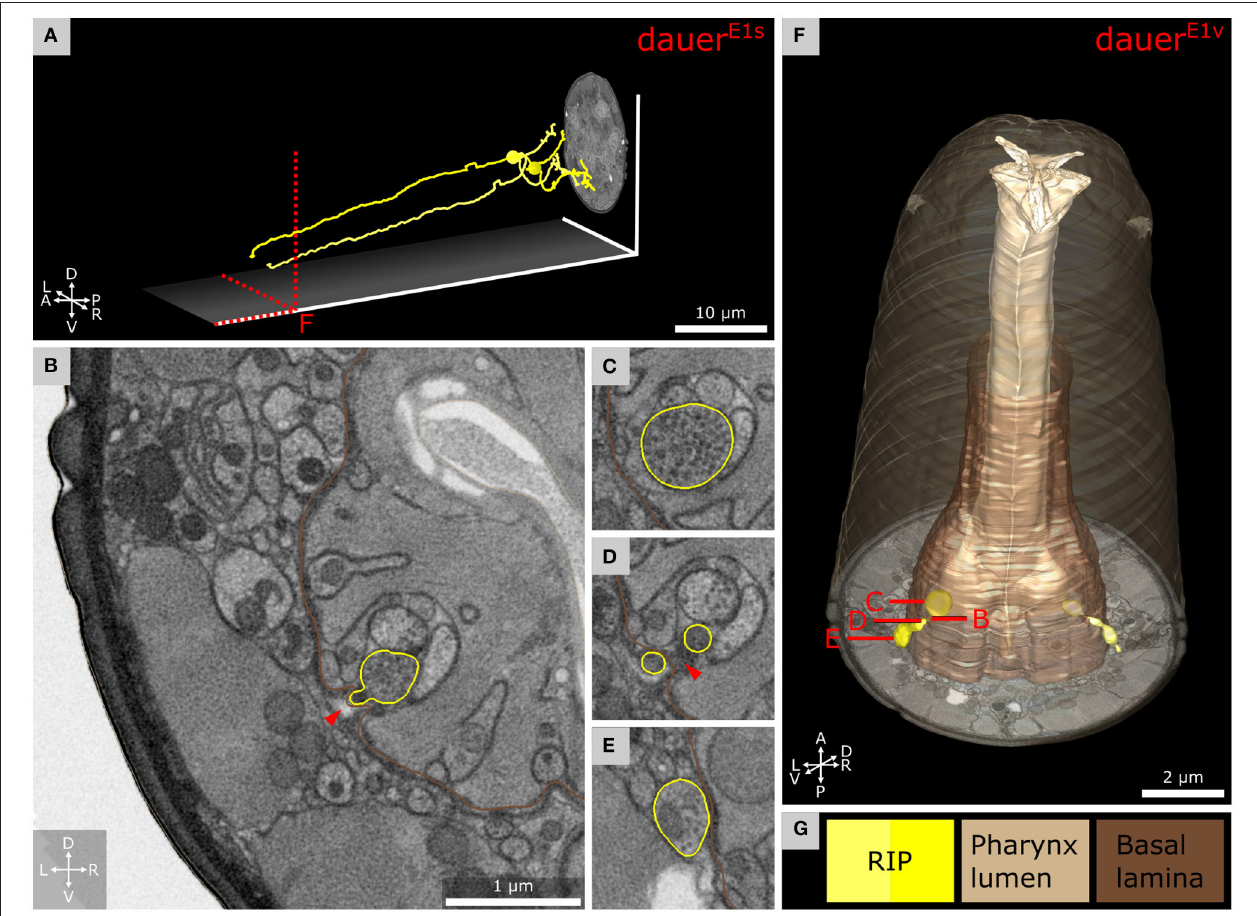
FIGURE 7 | Anterior dendritic endings of RIP neurons of dauer enter the pharyngeal nervous system. (A) Tracing of RIP neurons. (B) Transverse FIB-SEM section at the position where the ending of RIPR is entering the pharyngeal nervous system through an opening of the pharyngeal basal lamina. (C) Bouton with electron dense vesicles of RIPR inside the pharyngeal nervous system. (D) RIPR split at the pharyngeal basal lamina just before its ending is entering the pharyngeal nervous system. (E) Transverse section posterior of B where RIPR forms a small bouton filled with electron dense vesicles. (F) 3D reconstruction of RIP endings projecting through the pharyngeal basal lamina. (G) Names and color code of cells and structures